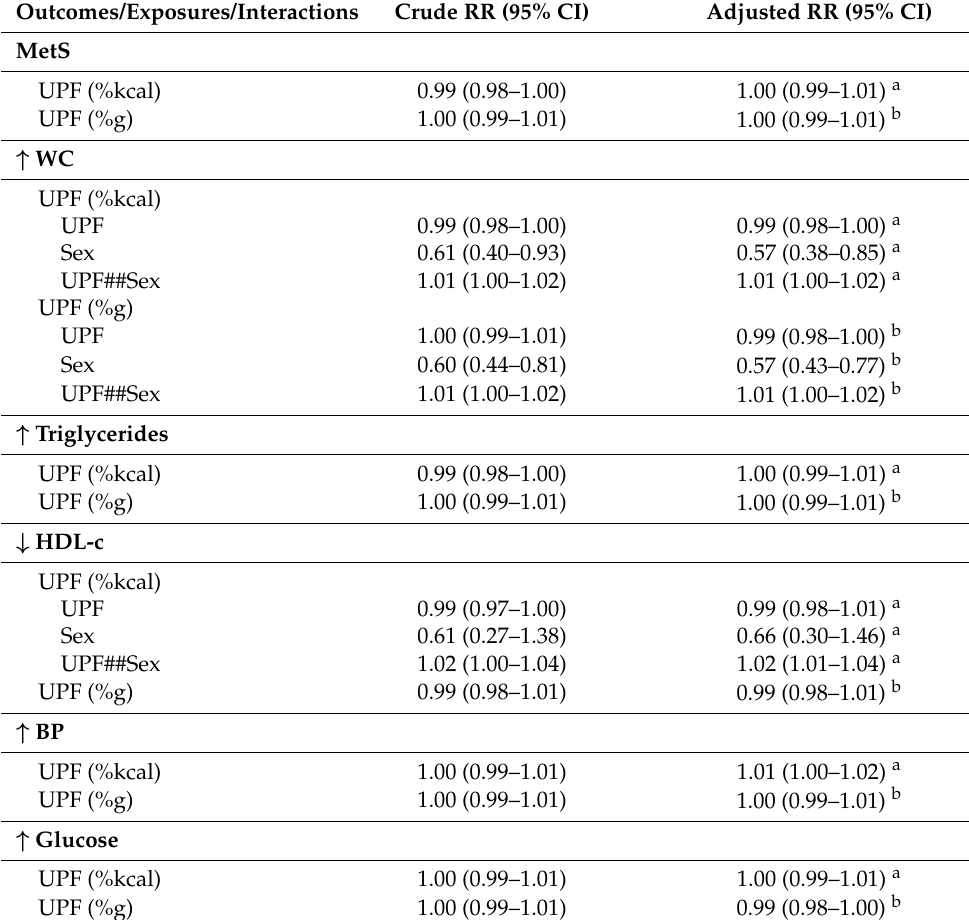
Table 3. Crude and adjusted analysis of the association between ultra-processed food (UPF) con- sumption at 23–25 years and risk of metabolic syndrome and its components at 37–39 years. Ribeir ã o Preto Cohort 1978/79, S ã o Paulo,